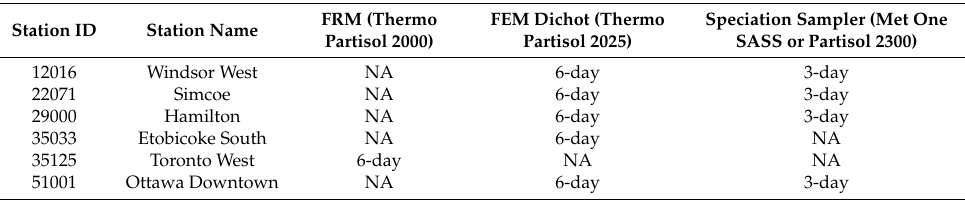
Table 1. Sampling frequencies of 24 h integrated samplers at six select